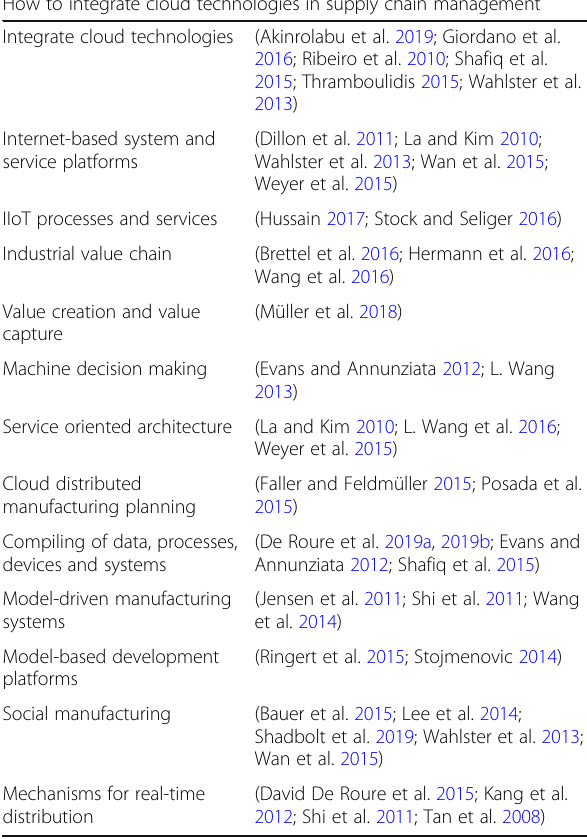
Table 3 How to integrate cloud technologies in supply chain management